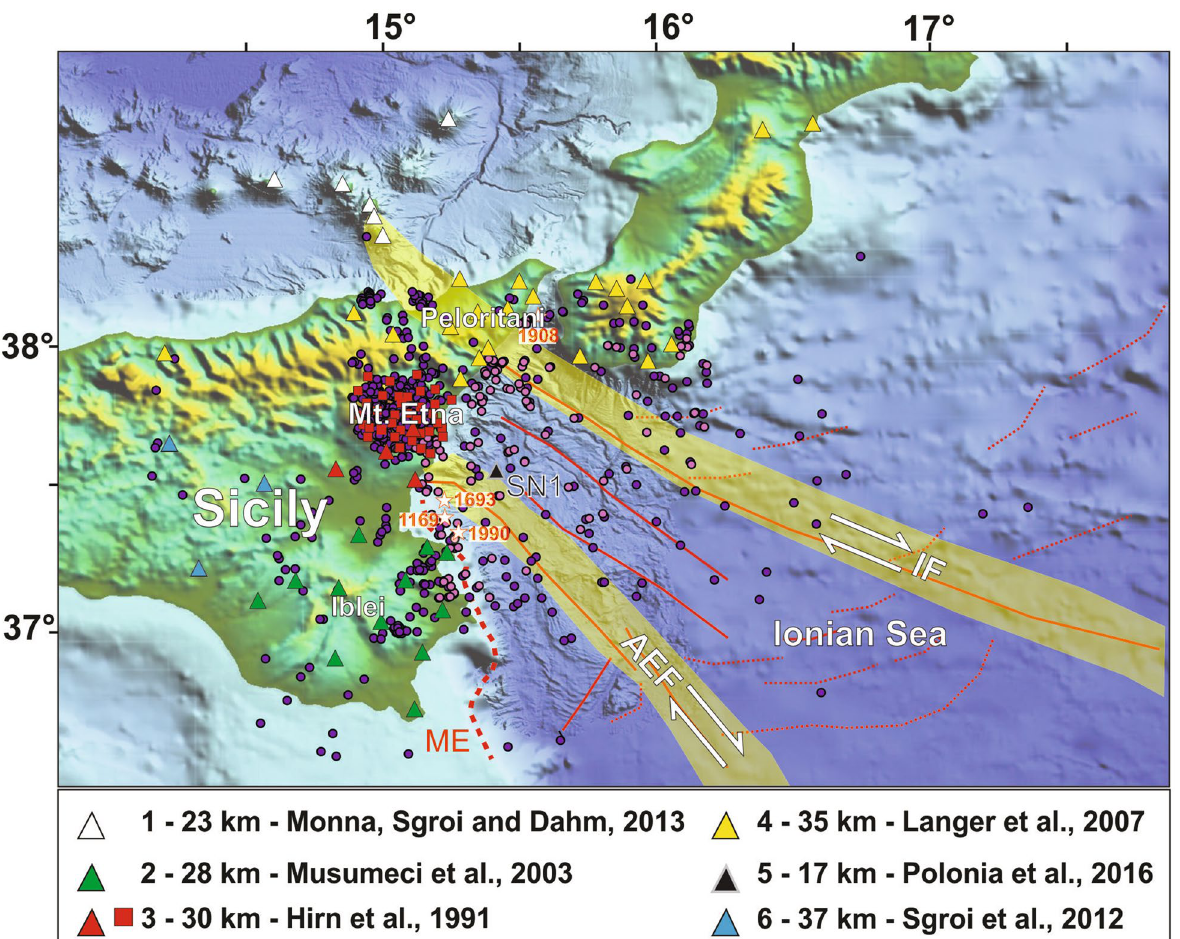
Figure 1. ( a ) Shaded-relief morphological map of the Western Ionian Sea and surrounding with indicated: main geological features, including Alfeo–Etna Fault (AEF) and Ionian Fault (IF) systems 11 , and Malta escarpment (ME); seismic stations used in this work (filled triangles: RSN; red squares: ERN). Colours of triangles and squares are related to the associated velocity models for the offshore-onshore south Calabria and Sicily (see legend for authors); violet and lilac dots indicate the preliminary relocations of 1020 earthquakes occurring in the study area during the deployment of the NEMO-SN1 seafloor station. Violet dots indicate the 912 (on 1020) earthquakes relocated through integration of handpicked travel times recorded by land stations and by NEMO-SN1; lilac dots are the selected earthquakes (108 on 1020) used to compute the new 1D velocity model for the Western Ionian Sea. The epicentres of the four highest magnitude earthquakes ever recorded in Italy 21 (1169, Mw 6.6; 1693, Mw 7.4; 1908, Mw 7.2; 1990, Mw 5.7) are indicated with white stars and years. Morphobathymetric data are from Global Bathymetry and Elevation Digital Elevation Model: SRTM30_PLUS v8 (https ://data.gov.au/data/datas et/globa l-hills hadin g-from-srtm3 0_plus-v8-0-nerp-te-13-1-eatla s-sourc e-ucsd/). The map was compiled using GMT package (version 6.0.0; https ://www.gener ic-mappi ng-tools .org/), and the image was edited using Adobe Illustrator (CS6; https ://www.adobe